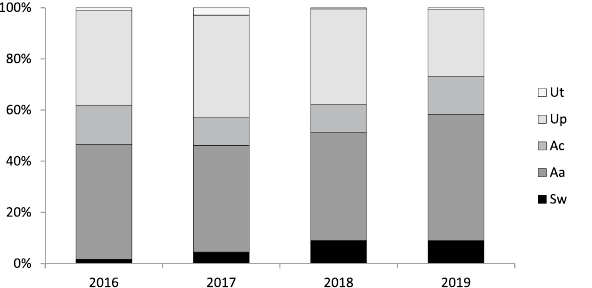
Figure 2. Relative frequencies of the co-occurring unionid mussels in 2016–2019. Ut, Unio tumidus ; Up, U. pictorum ; Ac, Anodonta cygnea ; Aa, A. anatina ; Sw, Sinanodonta woodiana . N 2016 = 350, N 2017 = 1198, N 2018 = 1058, N 2019 =